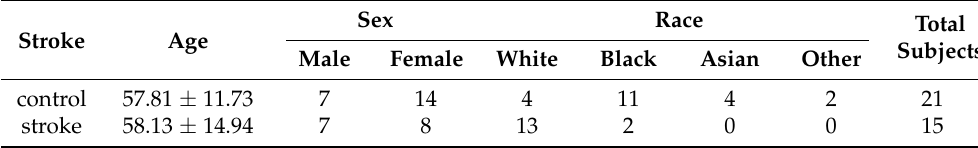
Table 2. Demographics for age-stroke-controlled cohort. Only ischemic stroke subjects are included.